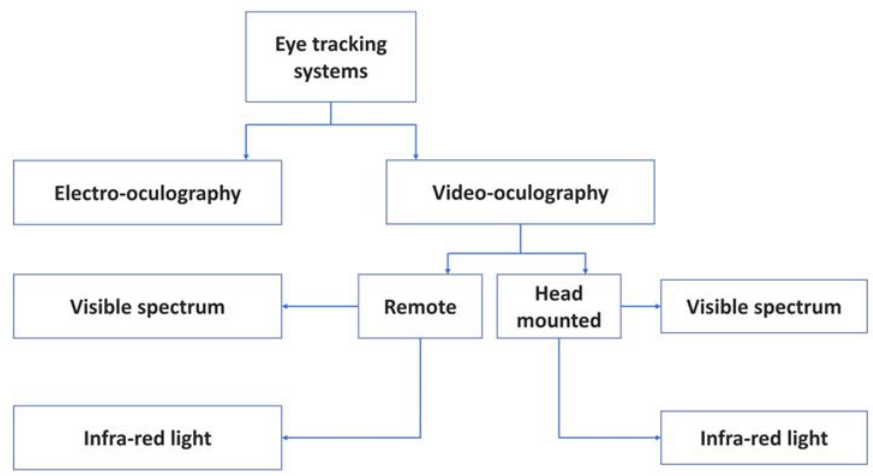
Figure 2. Di ff erent eye tracking Figure 2. Different eye tracking techniques.